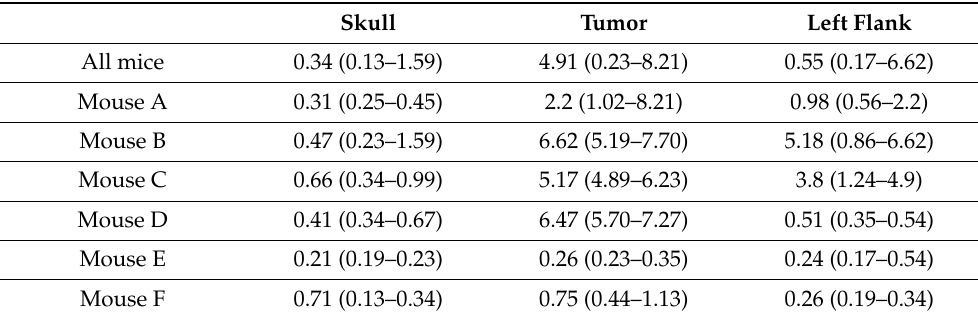
Table 1. The median values and range of ROI measurements of tumors and backgrounds. ROIs of quantified auditory data from tumors were higher than those of the background skull or left flank area. The values with statistical significance are highlighted in bold ( p <